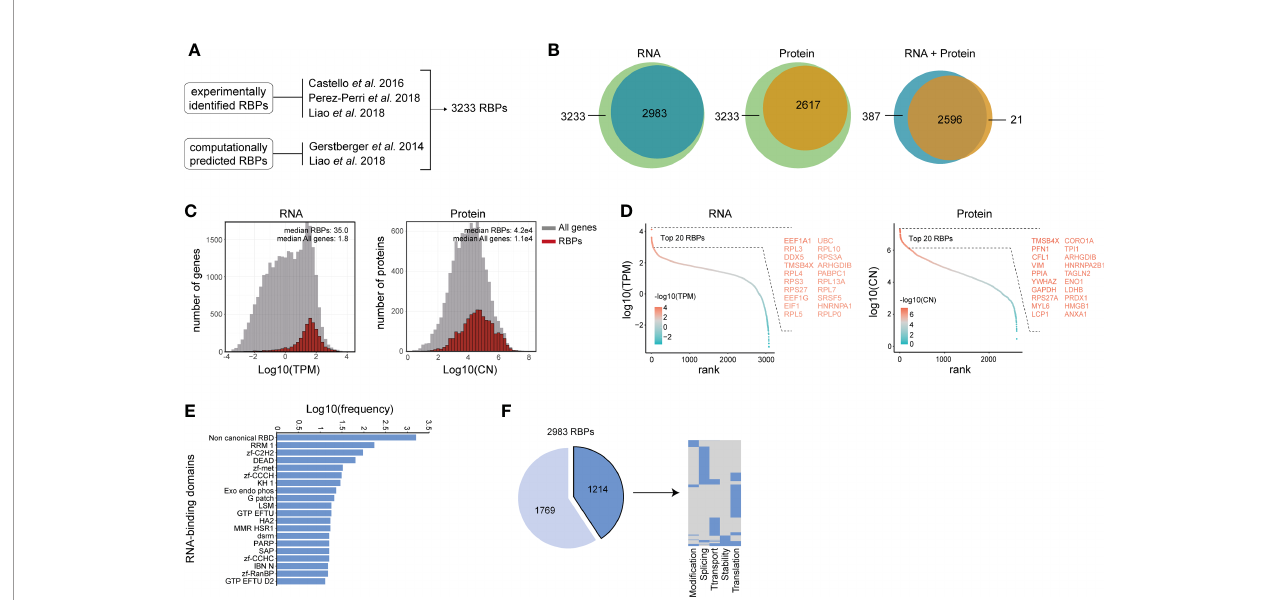
FIGURE 1 | Characterization of RNA-binding protein expression in human B and T lymphocytes. (A) Reference list of RNA binding proteins (RBPs) was generated by integrating experimentally validated RBPs (34 – 36) with computationally predicted RBPs based on the presence of a de fi ned list of RNA-binding domains (36, 37). (B) RBPs that are detected in human lymphocytes at RNA level (left panel), at protein level (middle panel), and at both RNA and protein level (right panel). RNA: n=3- 4 donors. Protein: 4 donors. (>0.1 TPM) (C) RNA abundance in transcript per kilobase per million (TPM) and protein abundance in protein copy number (CN) for all genes (gray) and RBPs (red) in human B cells and T cells. (D) Expression levels of RBPs detected at RNA level (left panel) and at protein level (right panel) was ranked according to expression levels. Names of the top 20 expressed RBPs are indicated. (E) Frequency of RNA-binding domains among the 2983 RBPs that were detected at RNA level. (F) Left panel: RBPs detected at RNA level in human B and T lymphocytes that are annotated for RNA splicing, stability, subcellular localization of RNA, RNA modi fi cation, and translation (dark blue), or for other processes (light blue). Right panel: Distribution of RBPs annotated for the fi ve RNA- related processes as indicated. Each line depicts one RBP. TPM, Transcripts per kilobase per million; CN, Protein copy